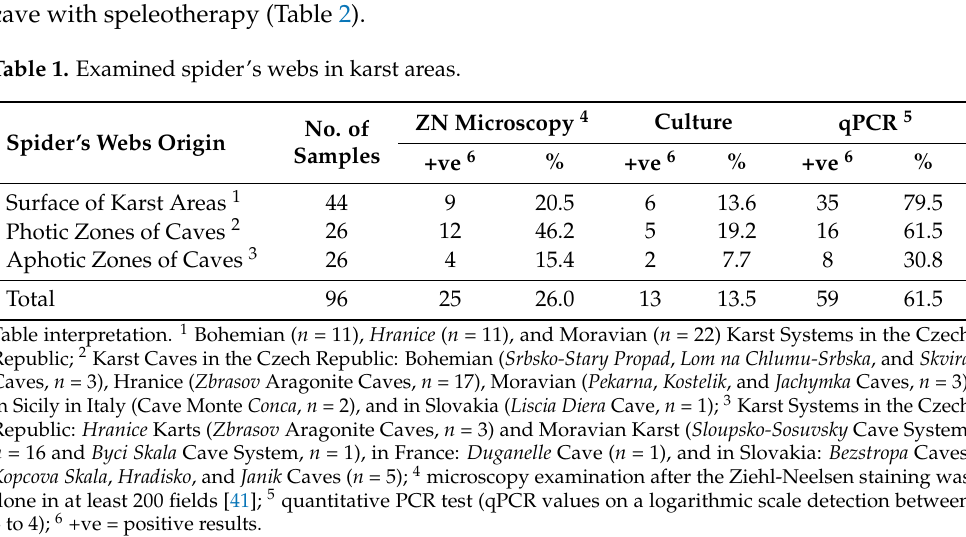
Table 1. Examined spider’s webs in karst areas.